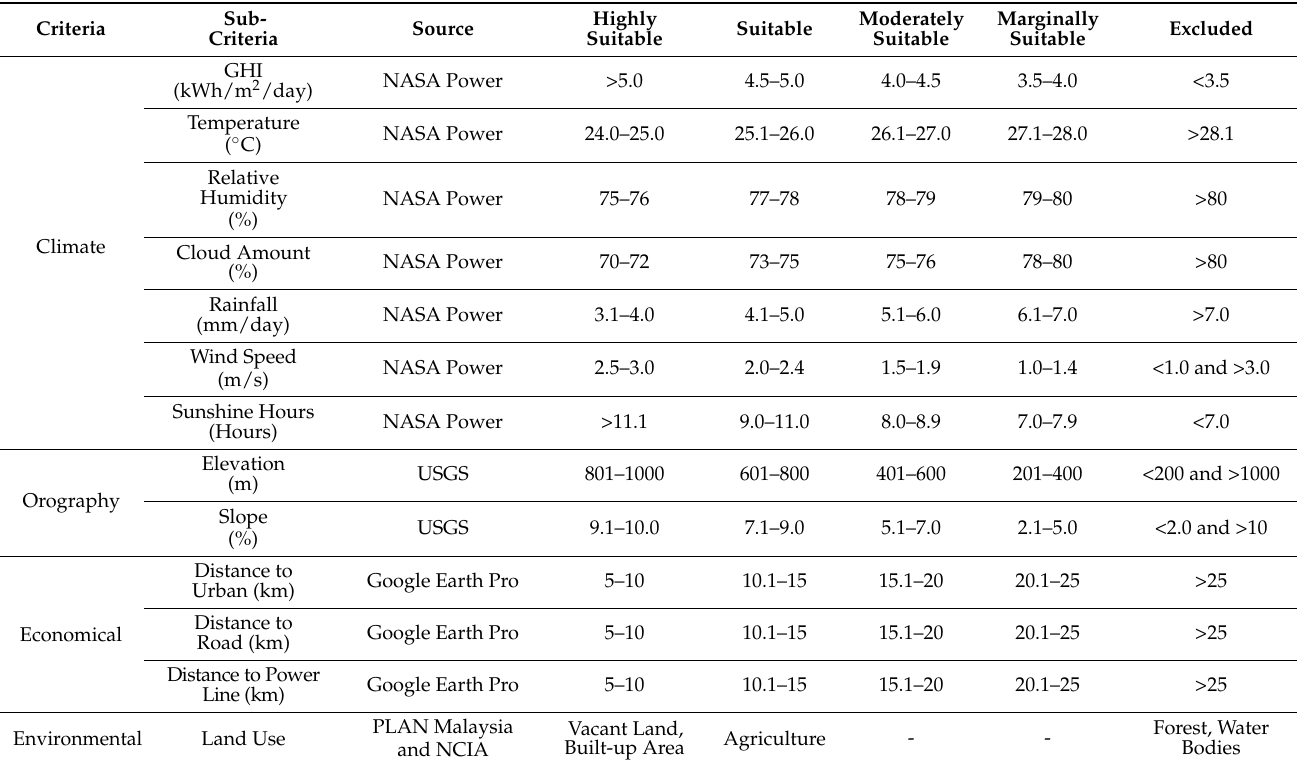
Table 4. The selected criteria and their suitability